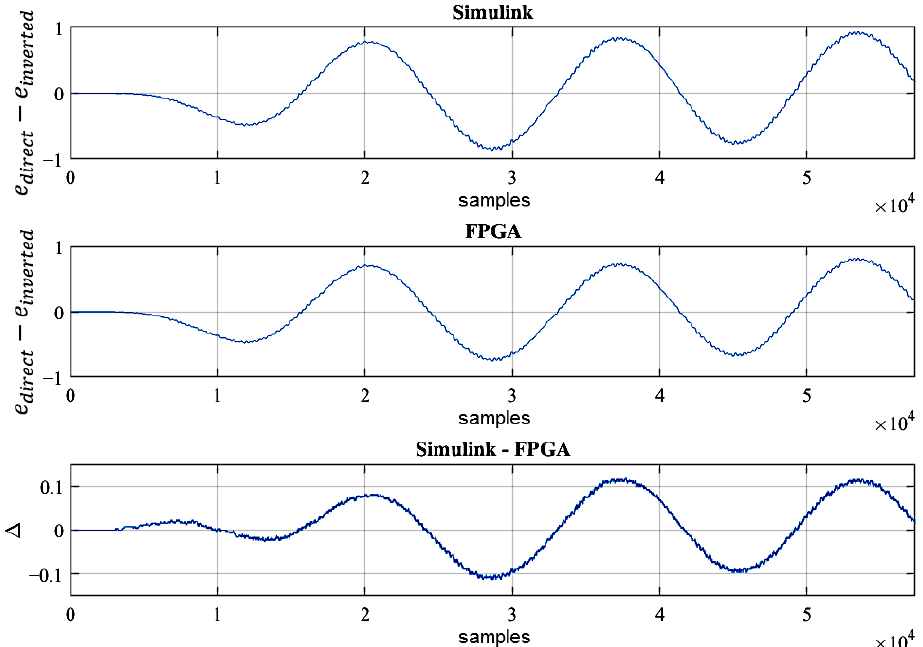
Figure 19. The signal of the difference between the mean values of the chaotic synchronization signals (at the direct and inverted signal input) obtained from the simulation of the Simulink model with a simplified analog channel model (upper graph), from the FPGA prototype with physical analog transmission via coaxial cable (middle graph), and the calculated difference between the two signals (bottom graph). Signals are obtained by transmitting the bit sequence “ 101010 ” .